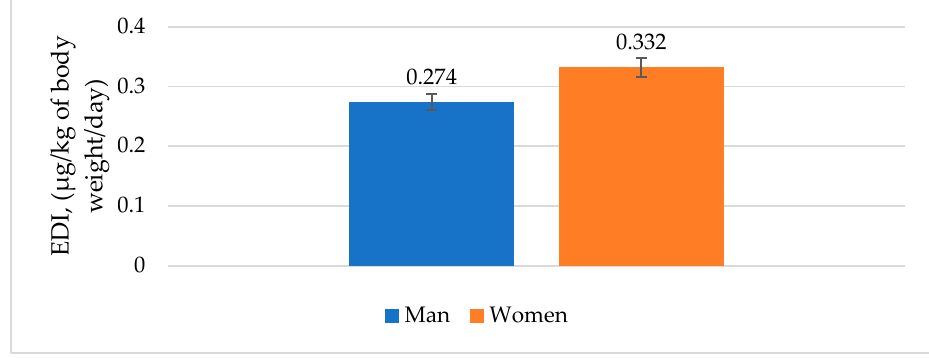
Figure 2. Acceptable daily intake (ADI) through freshwater fish consumption by men and women in Europe. The calculated EDI for freshwater fish in our research was 0.274 µg/kg of body weight/day for men and 0.332 µg/kg of body weight/day for women. The ADI value of antibiotics residues in fish meat was calculated to be 8.5 and 7.0 µg/kg of body weight/day for men and women, respectively. If fish were a major component of the diet, the contribution of investigated fish to dietary intake of total antibiotic residues would not seem to pose a risk to public health, according to the calculated EDI results. Despite limited toxicological data and approved standards, it is still difficult to estimate antibiotics’ potential risks to public health. In our research, the majority of antibiotic residues were under MRLs, but according to Wang et al. [62], people who consume meat, milk, and aquatic products daily might experience a long-term mixed exposure mode to multiple antibiotics of low-dose less than 1µg/kg/day. In earlier studies by the same authors [63], adverse effects of level antibiotics in urines were associated with children’s obesity, suggesting multiple potential health risks from antibiotic residues in used food products. 3. Materials and Methods 3.1. Design of Study and Fish Sampling A total of 15 samples of 3 species of fish samples ( n = 5 per species) such as common carp, silver carp, and grass carp were randomly collected from the different local fish markets and supermarkets in Novi Sad during November 2019 and transported immediately to the laboratory and stored till further analyses. For the isolation and enumeration of bacteria, 10 g of each sample was homogenized in 90 mL normal saline and diluted up to 10 − 5, and aliquots were seeded onto tryptone soya agar plates by spread plate technique in duplicate. The color, opacity, shape, and structure of colonies were used